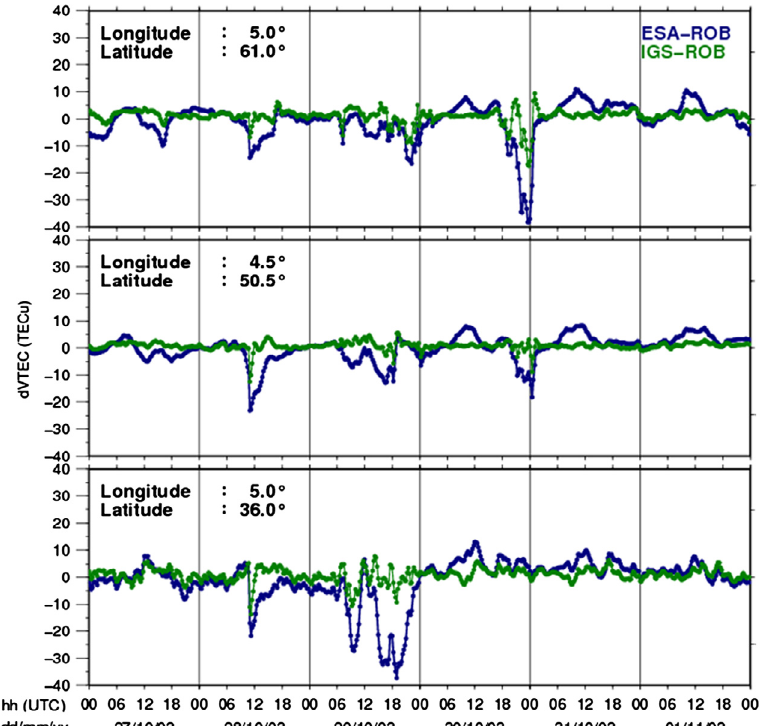
Fig. 5. Differences between ESA/IGS products and ROB-TEC maps during the 2003 Halloween storm. The 6-day time-series represent the differences between the vTEC extracted from ESA (blue) and IGS (green) maps with ROB-TEC maps at three different geographic locations shown on Figure